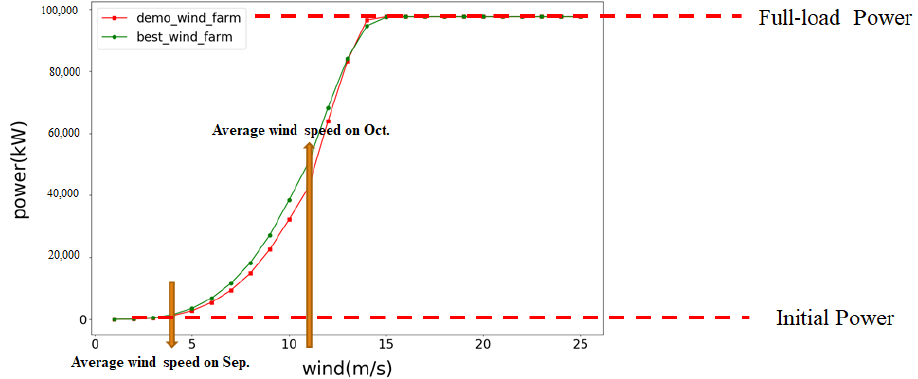
Figure 11. The power comparison of the optimized windfarm and the conventional windfarm.